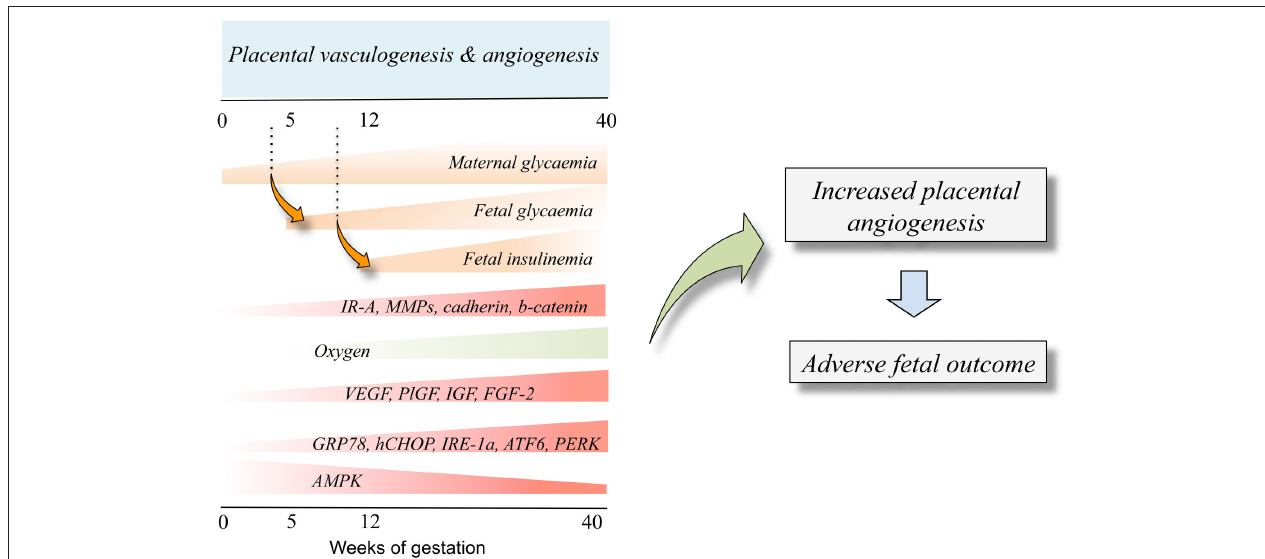
FIGURE 2 | Fetal insulinemia and altered angiogenesis in fetoplacental endothelium from gestational diabetes mellitus. With the progression of pregnancy up to the 40th weeks of gestation, the maternal glycaemia increases, and could reach supraphysiological levels in pregnancies where the mother is diagnosed with gestational diabetes mellitus. The maternal hyperglycaemia results in increased fetal glycaemia from about the 5th week of gestation (dotted line), a condition resulting in a supraphysiological increase of fetal insulinemia from the 12th week of gestation. Increased fetal insulinemia results in altered placental vascular development and growth leading to angiogenesis alterations ( Placental vasculogenesis and angiogenesis ). Thus, an adverse fetal outcome is seen as a result of abnormal angiogenesis. Cell signaling mechanisms involved in this phenomenon include altered expression and/or activity of several molecules that are responsive to